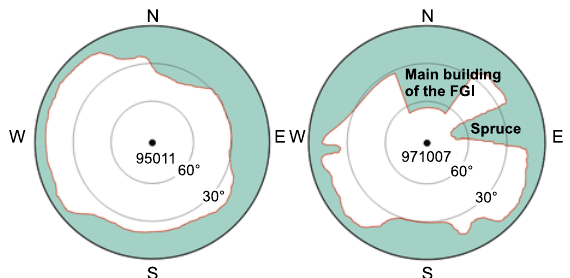
Fig. 3. Sky plots from the benchmarks 95011 and